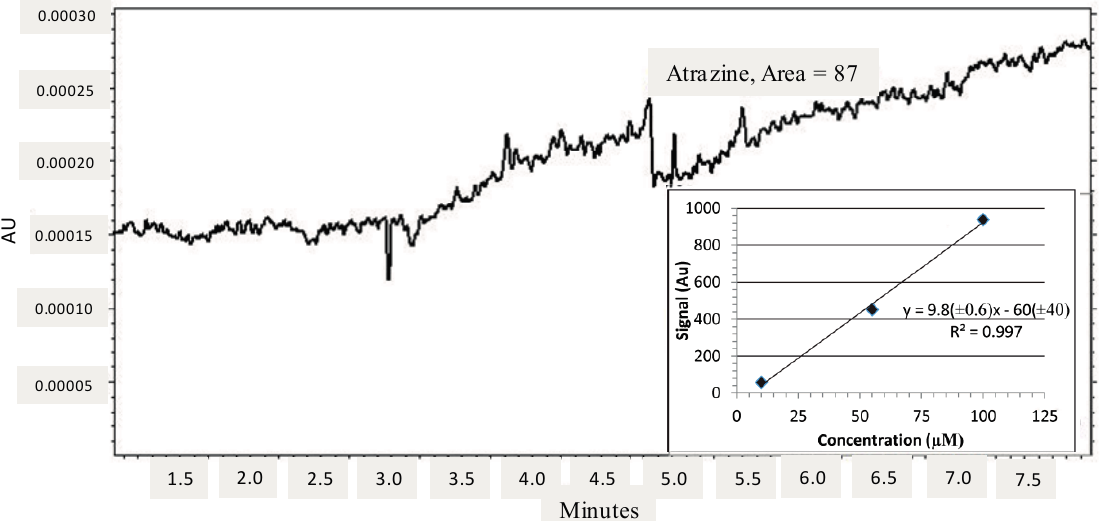
Figure 5. Separation and detection of MRE-bound atrazine from processed river water at an absorbance of 225